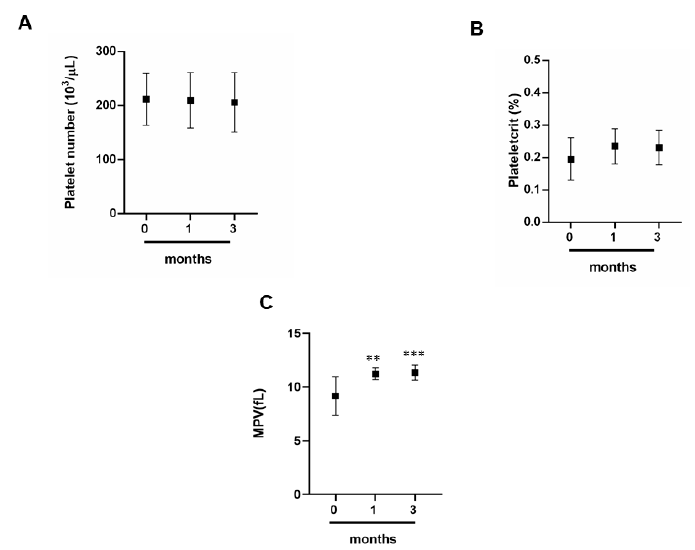
Figure 2. Platelet indices. ( A , B , C ) Assessment of percentages of red blood cells at different times 0, 1 and 3 months by a group of 12 professional basketball athletes. Data expressed as the mean ± SD. Significance determined by the t- test student; ( C ) 0 months versus 1 months ** ( p = 0.0010) and 0 months versus 3 months *** ( p = 0.008). MPV, mean platelet volume.